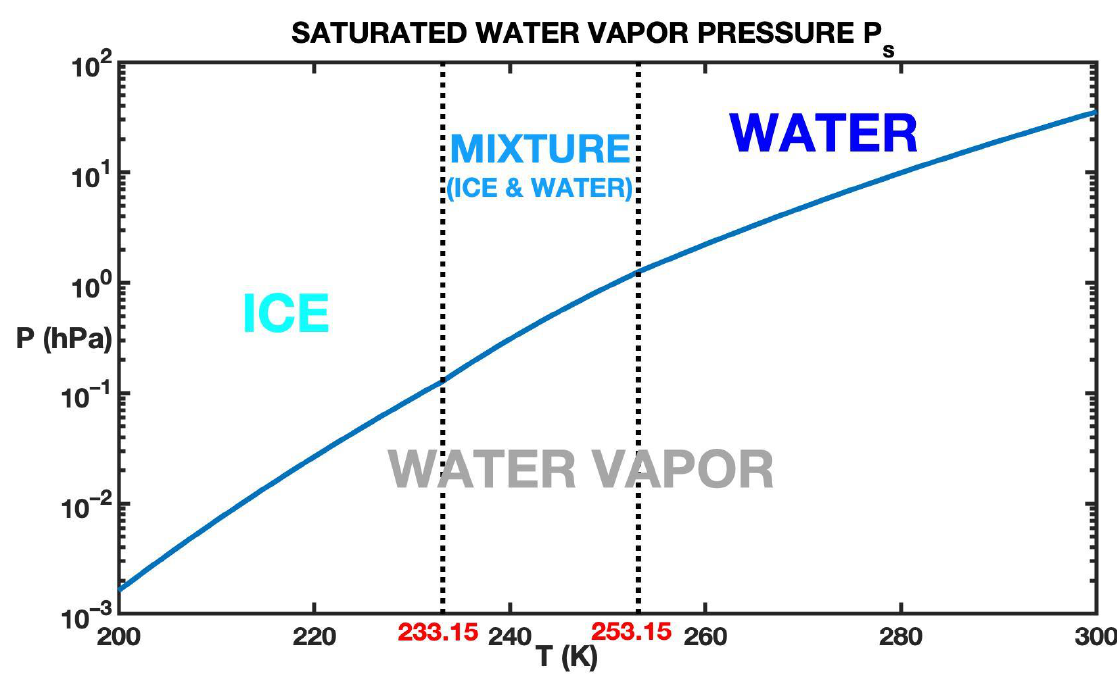
Figure 9. Phase transition curve between water vapor and ice and between water vapor and water used in this study. For “mixture” we intend the intermediate region where the saturated water vapor pressure is given by a linear combination of the saturated pressure with respect to ice and water.